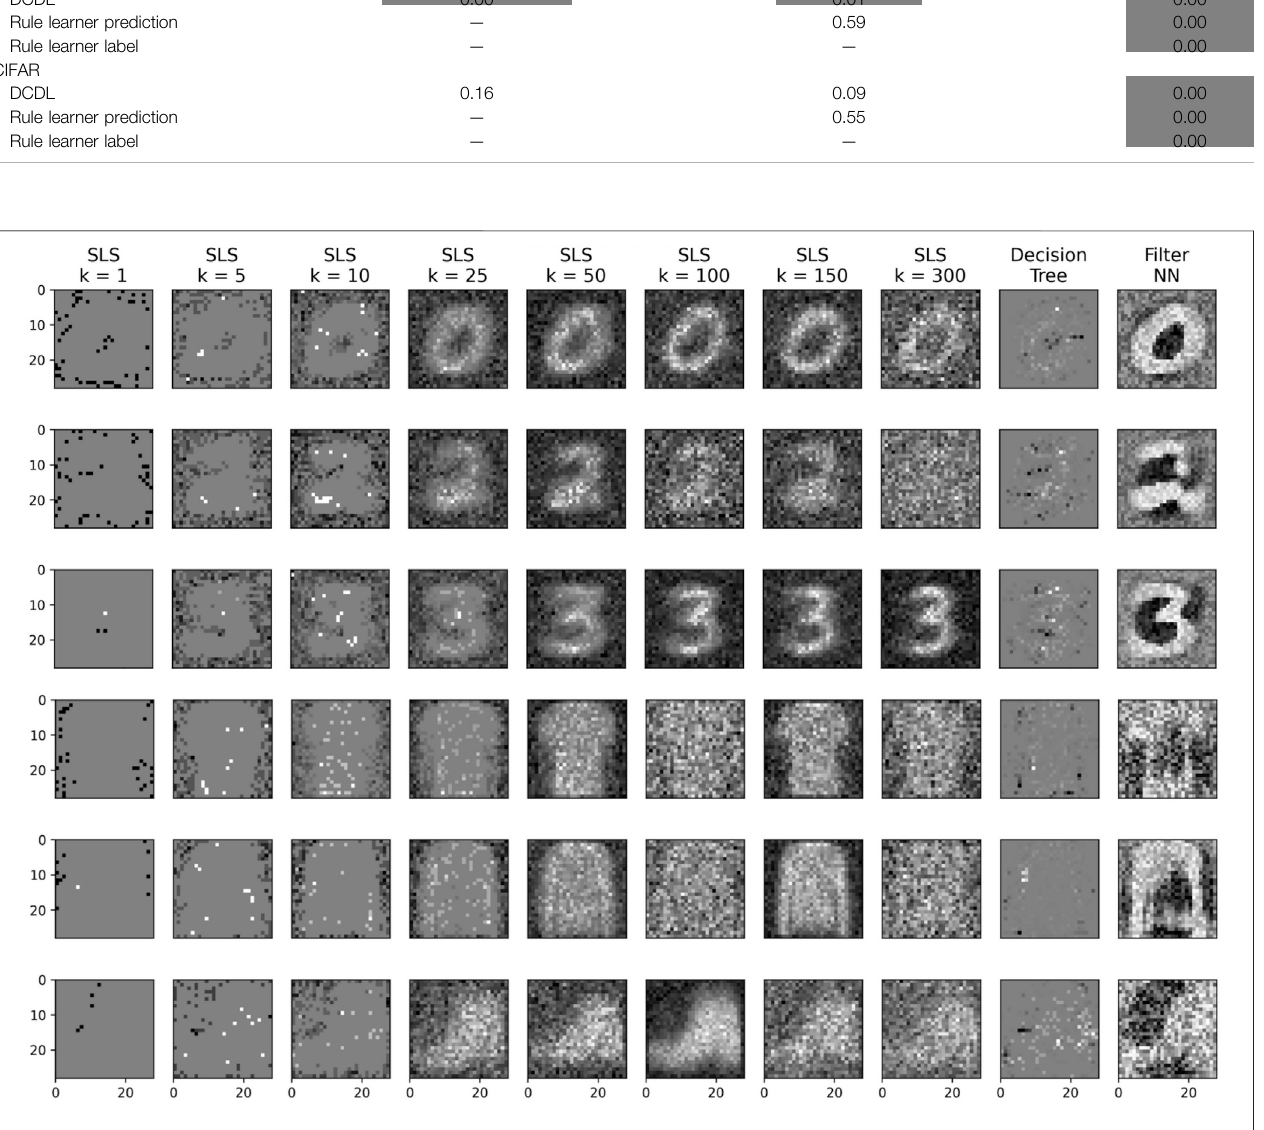
Frontiers in Arti fi cial Intelligence |